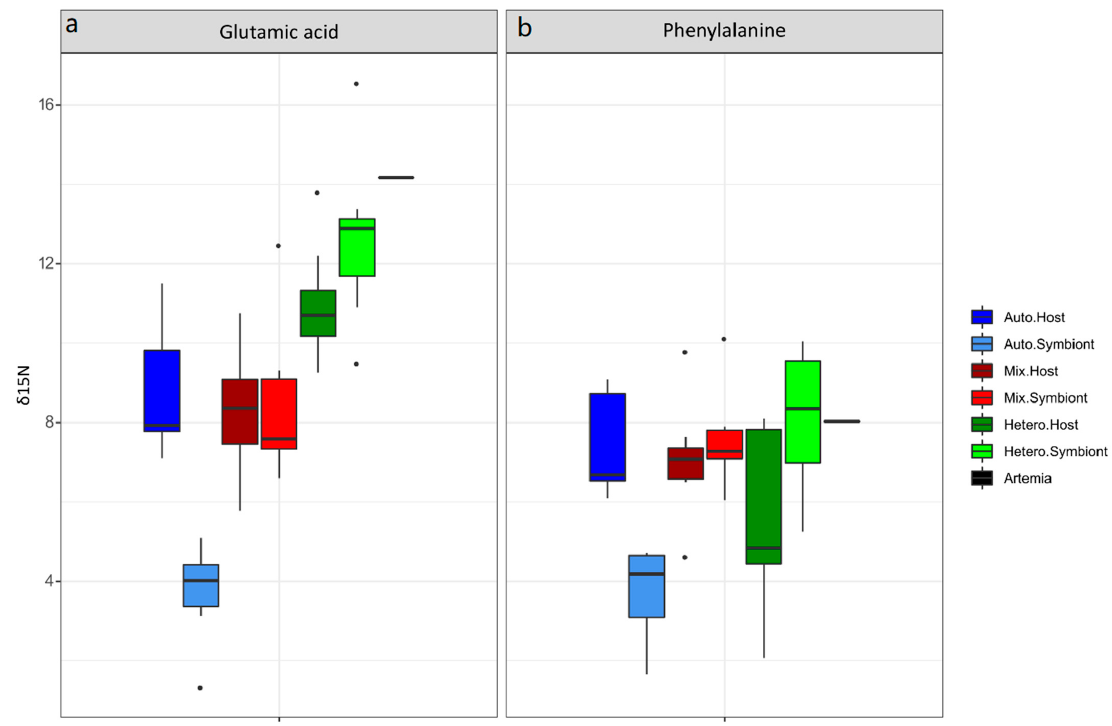
Figure 2. Changes in the δ 15 N value of the ( a ) glutamic acid and ( b ) phenylalanine according to the nutritional state of the coral holobiont: autotrophic host and symbionts are represented in blue, the mixotrophic host and symbionts in red and the heterotrophic host and symbionts in green.